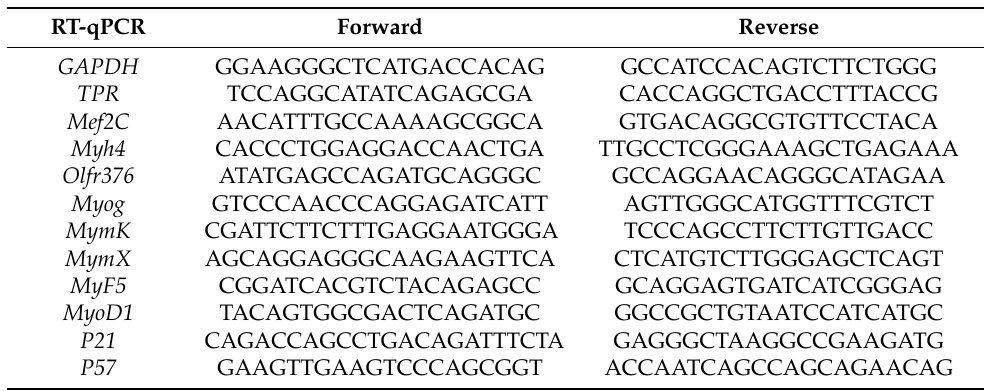
Table 5. Primers used for